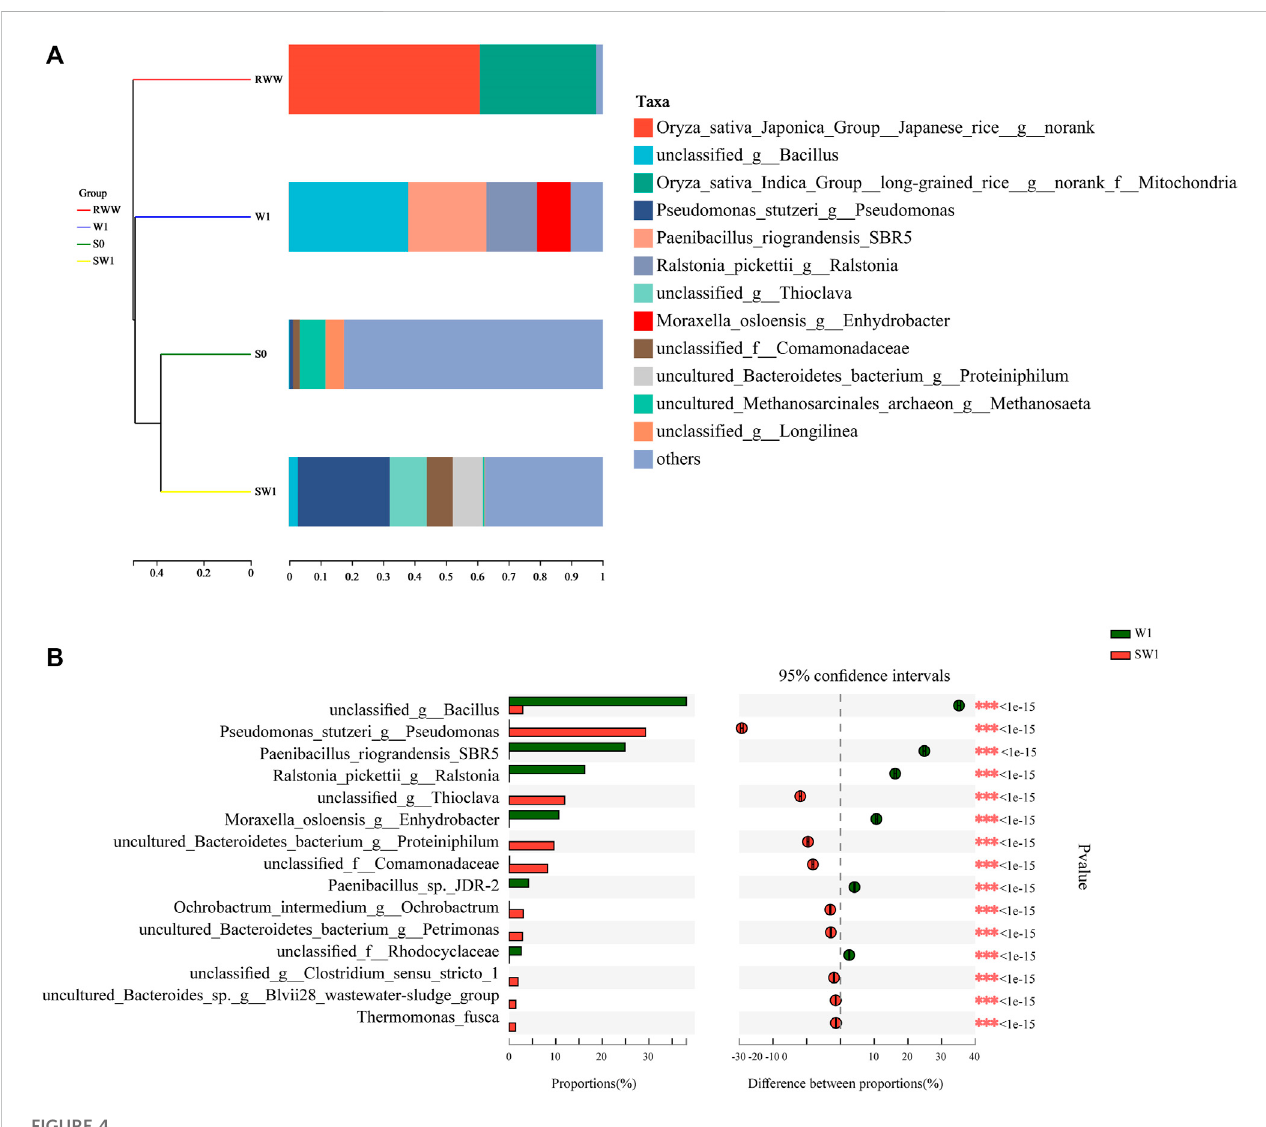
FIGURE 4 Hierarchical clustering tree (A) and Fisher ’ s exact test bar plot (B) on the species